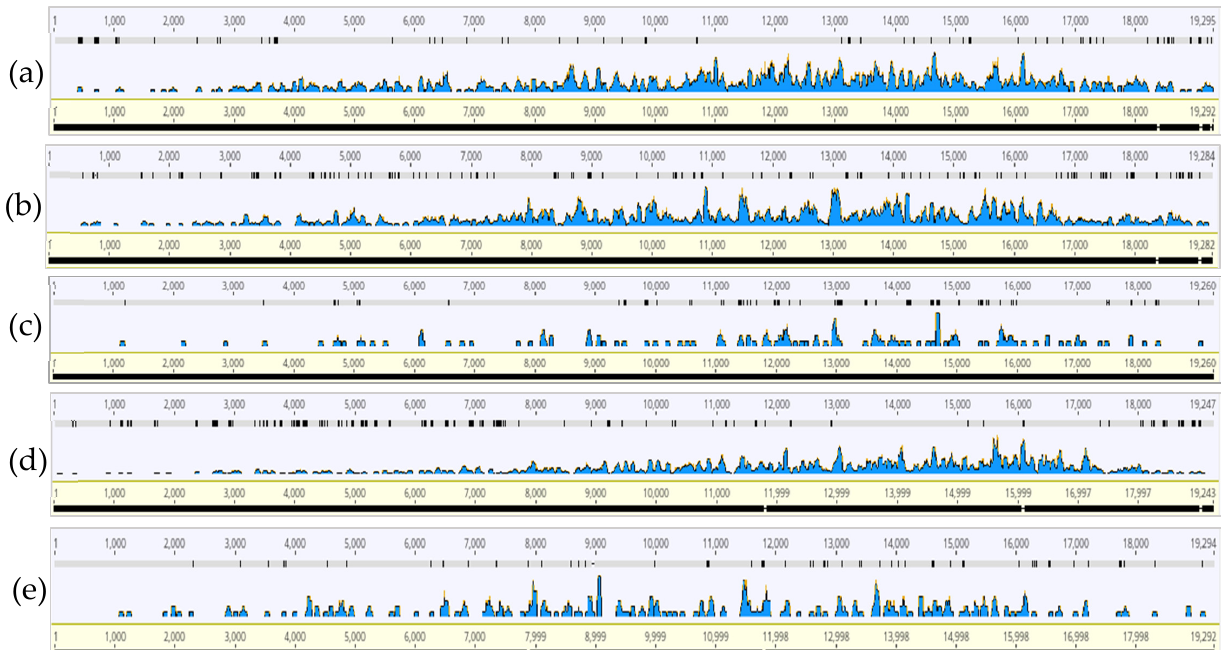
Figure 1. Read coverage and distribution profile generated from each Florida Region of 2019 aligned to the respective citrus tristeza virus (CTV). ( a ) Region A (CTV T36, KC517485.1); ( b ) Region B (CTV T36, KC517485.1); ( c ) Region C (CTV T36, KC517488.1); ( d ) Region D (CTV RB, KU358530.1); ( e ) Region E (CTV VT, KC748392.1).